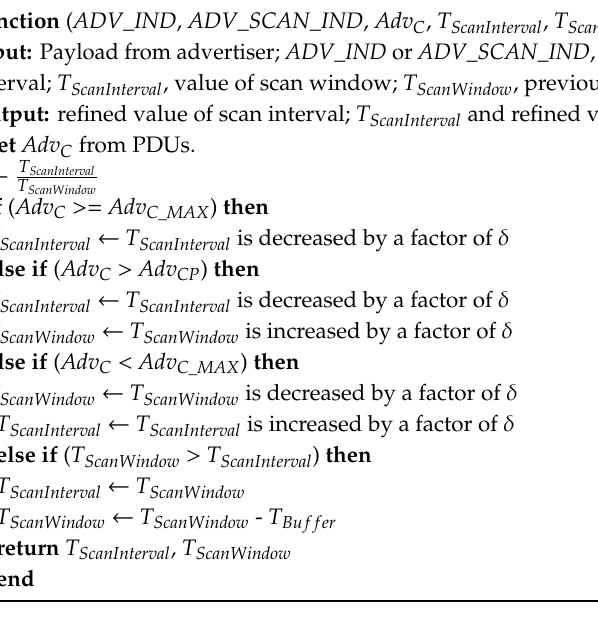
Algorithm 1. Proposed